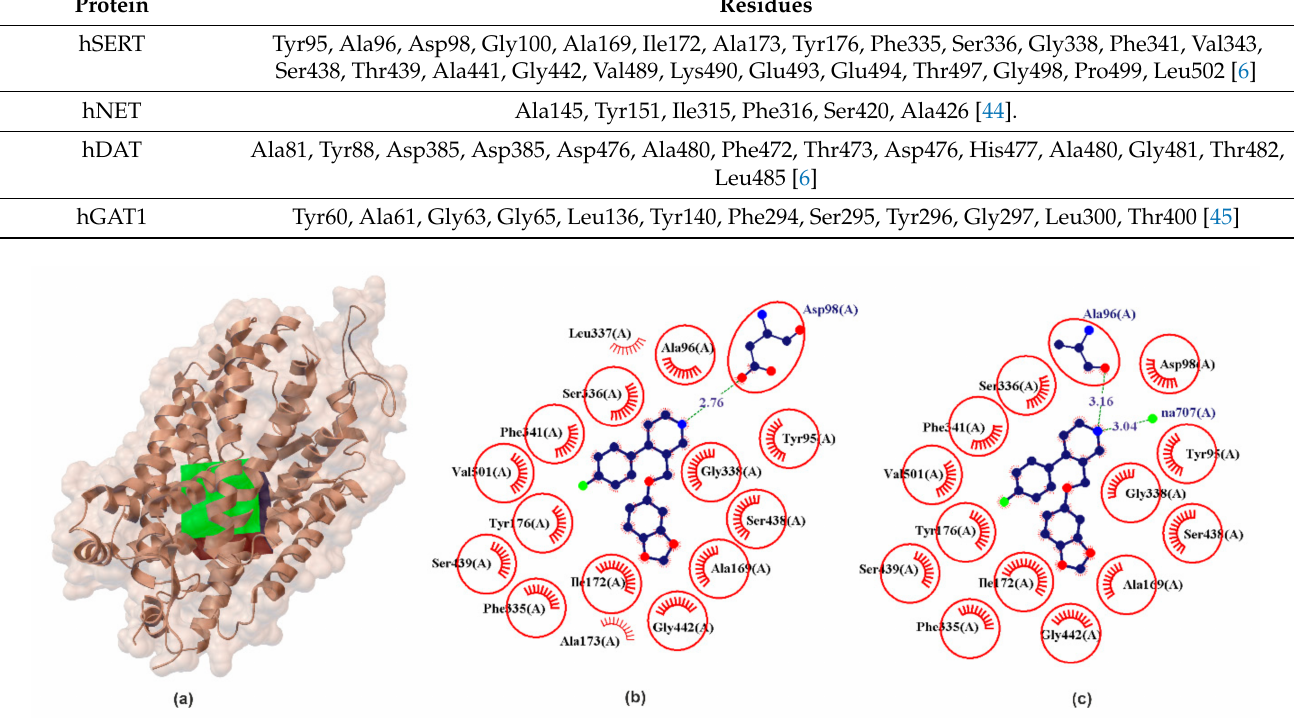
Figure 2. X-ray structure of the hSERT crystal ( a ) with the grid box showing the ligand-binding site (PDB ID: 5i6x, 3.14 Å). Comparison between calculated ( b ) and crystallographic data ( c ) for binding pocket in PRX–hSERT complex. The red circles and ellipses identify equivalent residua (in 3D superposition of